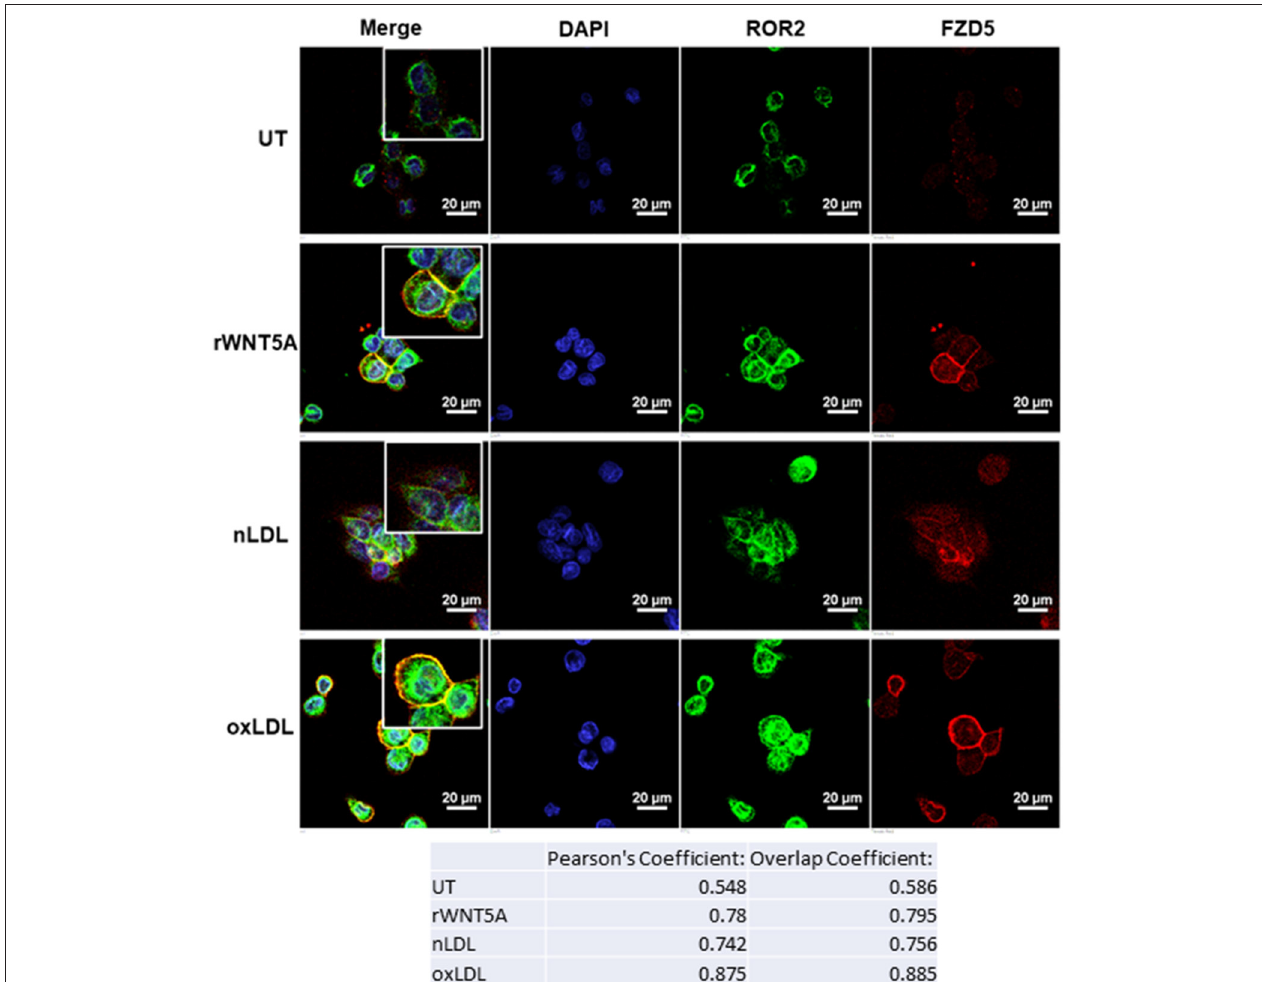
FIGURE 5 | WNT5A Receptors, FZD5 and ROR2, are Co-localized in vitro in Response to oxLDL and WNT5A. Representative confocal immunofluorescence (IF) images of THP-1-derived macrophages. Cells were differentiated with PMA for 24h and then treated with rWNT5A (100ng/mL), (nLDL) or oxLDL (both 100 µ g/mL) for an additional 24h. Cells were then fixed, dual-stained with FZD5 (Red) and ROR2 (Green), and counterstained with 4 ′ ,6-diamidino-2-phenylindole (DAPI). Compared to untreated cells (UT), rWNT5A increased the co-localization of the FZD5 and ROR2 receptors at the plasma membrane (Pearson’s Correlation: UT = 0.548, rWNT5A = 0.78). Further, oxLDL-treated cells showed an even greater increase in co-localization of the FZD5 and ROR2 receptors compared to all groups (Pearson’s Correlation: oxLDL = 0.875). Immunofluorescent images are at 60x with equally zoomed insets for clarity (scale bar = 20 µ m). Experiments were performed in duplicate and repeated three independent times. Representative negative control and isotype control images are included in the data supplement ( Supplementary Figure 2 ).